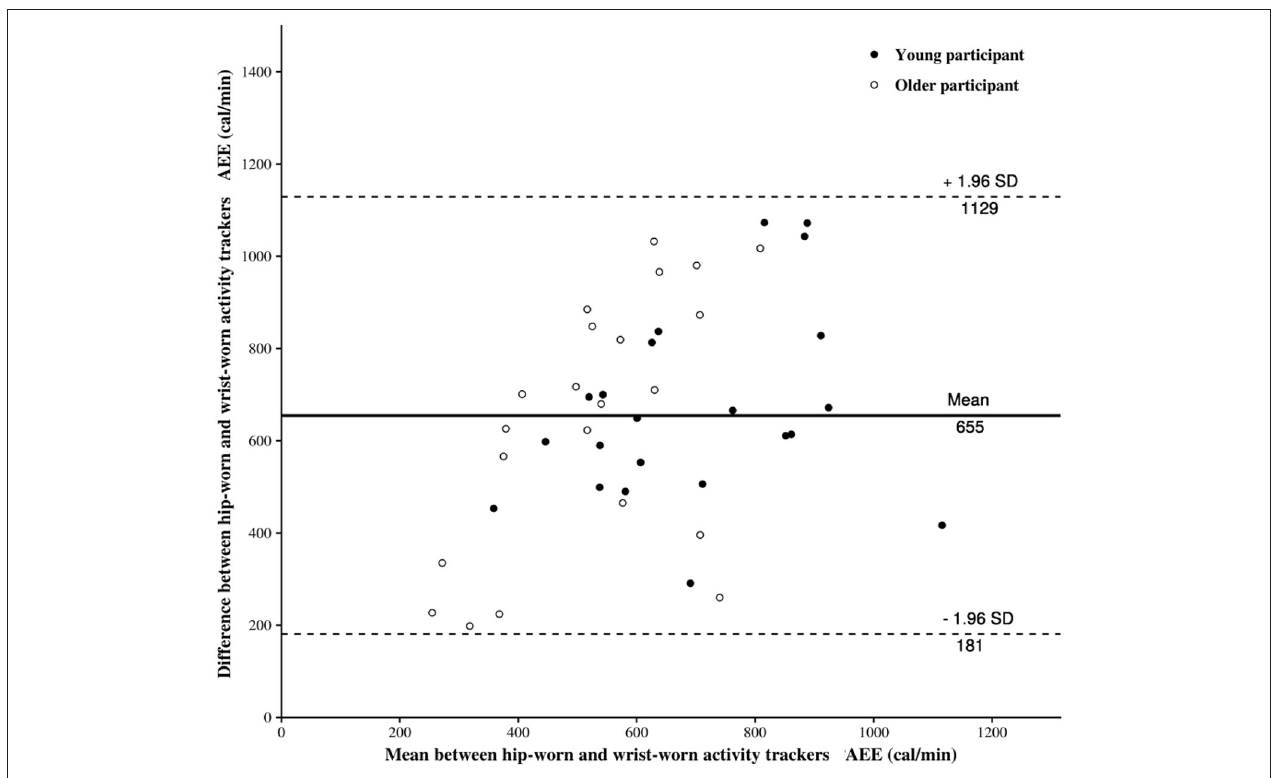
FIGURE 3 | The Bland-Altman plot for the active energy expenditure (AEE) provided by hip-worn and wrist-worn activity